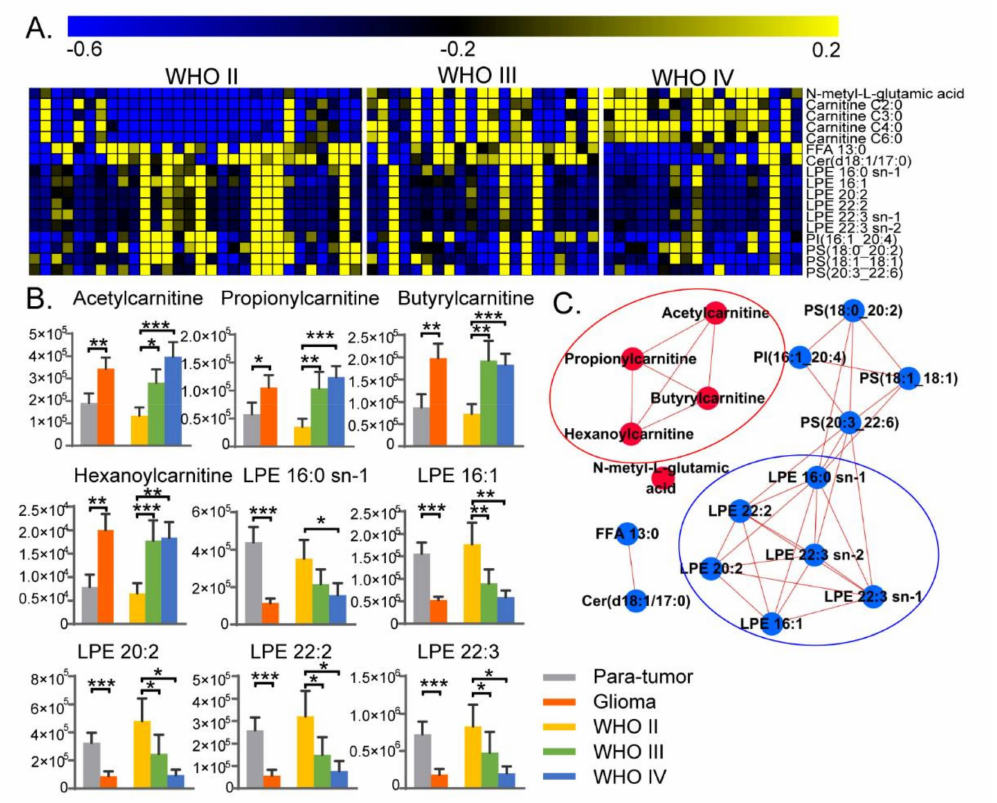
Figure 3. Statistical analysis for di ff erent grades of glioma tissues. ( A ) Heatmap showing the 17 important metabolites for di ff erent grades of glioma tissues. ( B ) Histogram of important metabolites related to short-chain acyl-carnitines and lysophosphatidylethanolamines (LPE). ( C ) Correlation network analysis of the 17 important metabolites for di ff erent grades of glioma tissues. Significance level, * p < 0.05, ** p < 0.01, *** p <